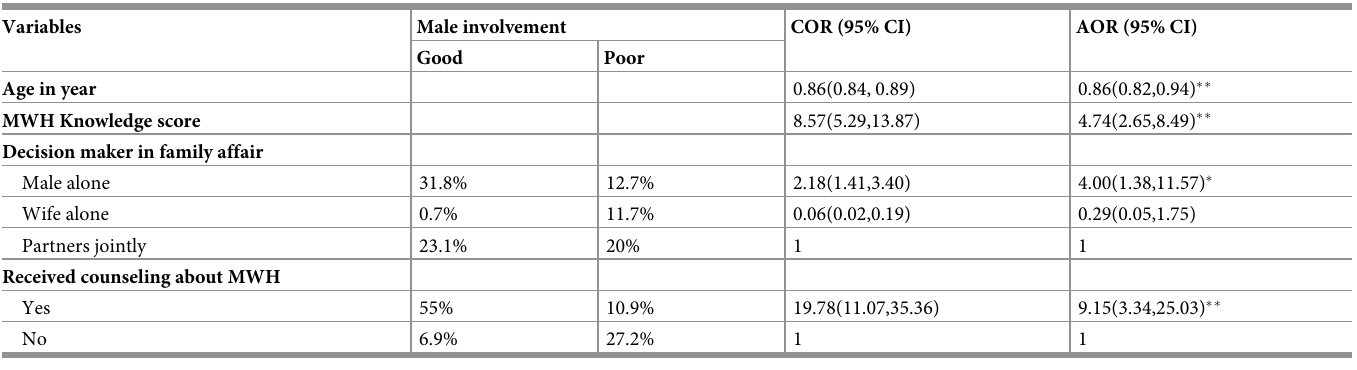
Table 5. Factors affecting male partners’ involvement in MWH utilization in North Achefer district, 2018.